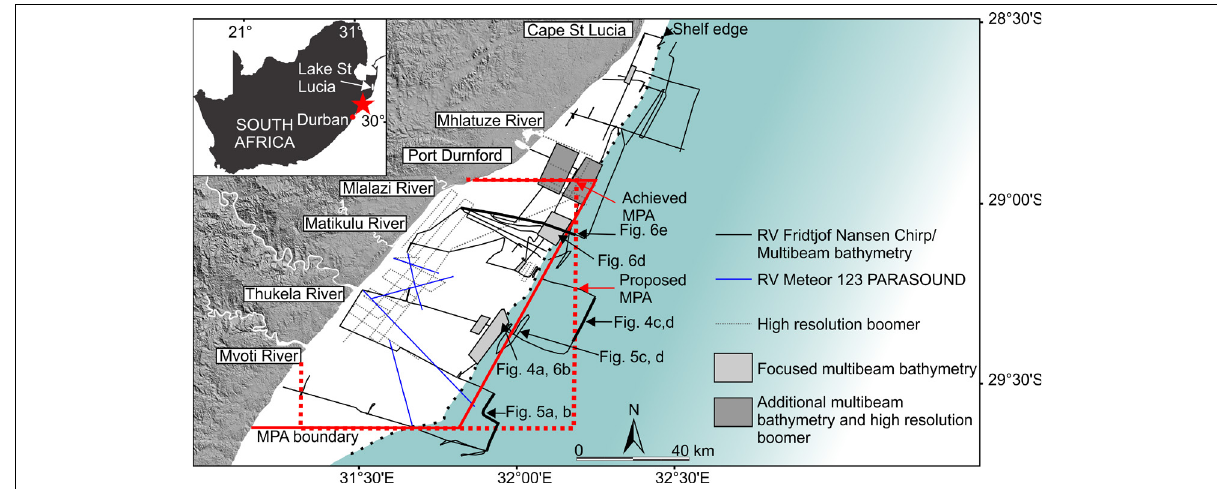
Figure 1: Locality of the uThukela Marine Protected Area (MPA). The solid red line indicates the current MPA limits and the dashed red line indicates the original proposed MPA boundaries. Line tracks for the various geophysical data sets are shown. These include ultra-high resolution Topas seismic reflection and multibeam data (solid black – RV Fridtjof Nansen ), ultra-high resolution PARASOUND (solid blue) and high-resolution boomer seismic reflection (dotted dark grey). The shelf edge is shown by the black dotted line. Bold lines are seismic reflection profiles shown in figures.